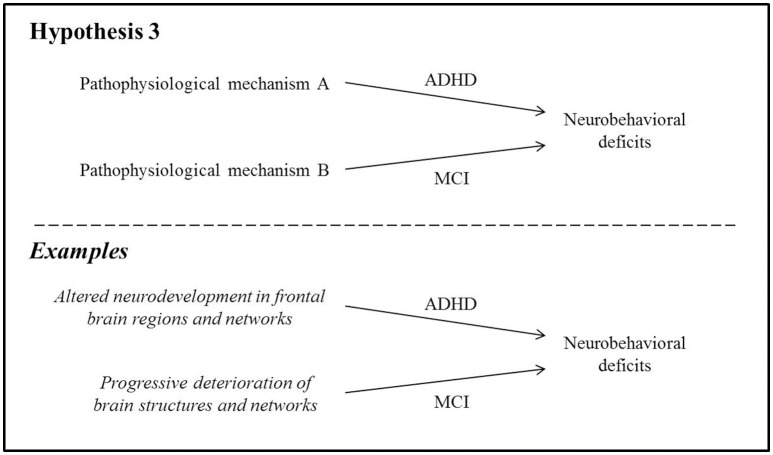
The pathophysiologies of ADHD and MCI are fundamentally unrelated despite similar neurobehavioral symptoms.